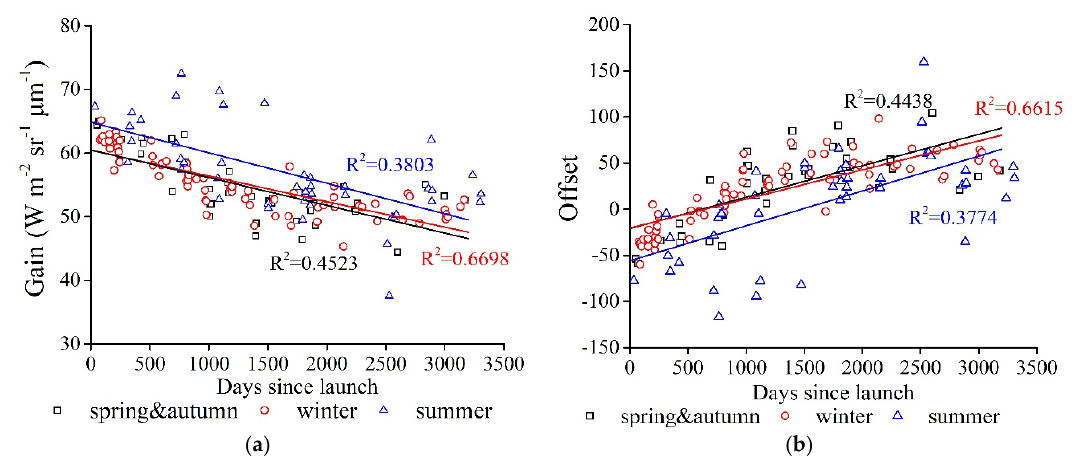
Figure 13. Changes in radiation calibration coefficients in different seasons. ( a ) Gain changes in different seasons; ( b ) offsets changes in different seasons.